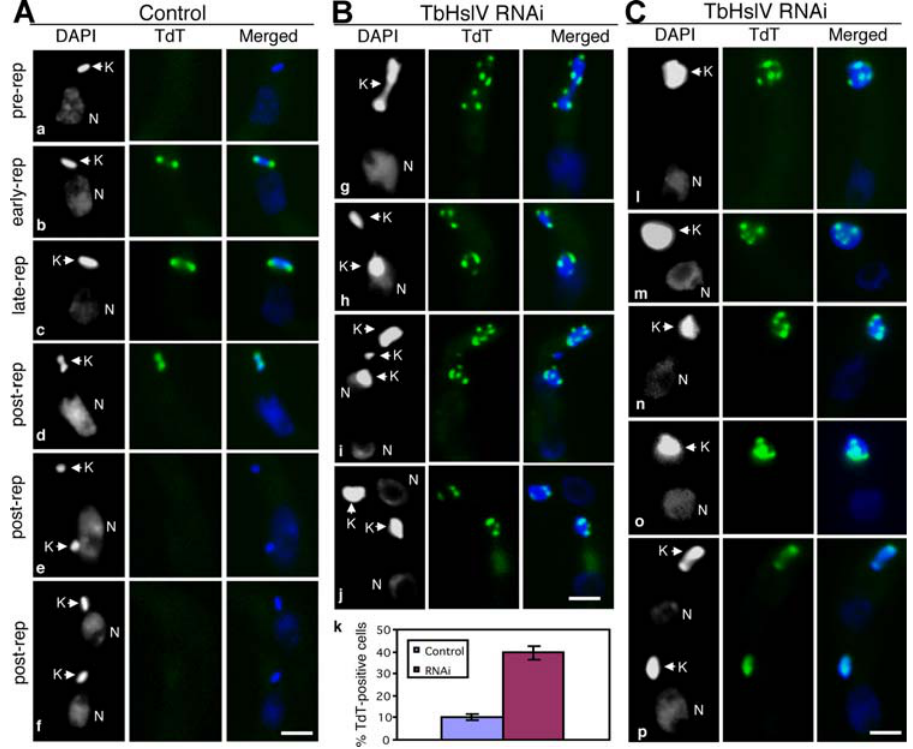
Figure 6. Insitu TdT-catalyzed Fluorescein-dUTP labeling in cells after 7 days of TbHslV RNAi. ( A ). The control cells ( a – f ). ( B , C ). The TbHslV RNAi cells ( g – p ). Percentages of TdT-labeled cells in control and TbHslV RNAi cells are presented ( k ). Bars: 2 m m.